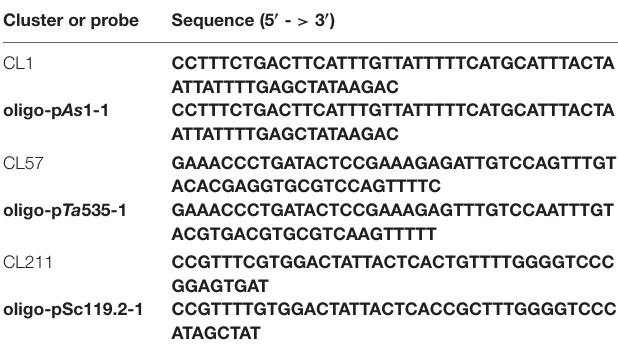
TABLE 1 | Partial sequences of the identified Ae. tauschii satellite clusters homologous to the oligonucleotide probes used in the present study